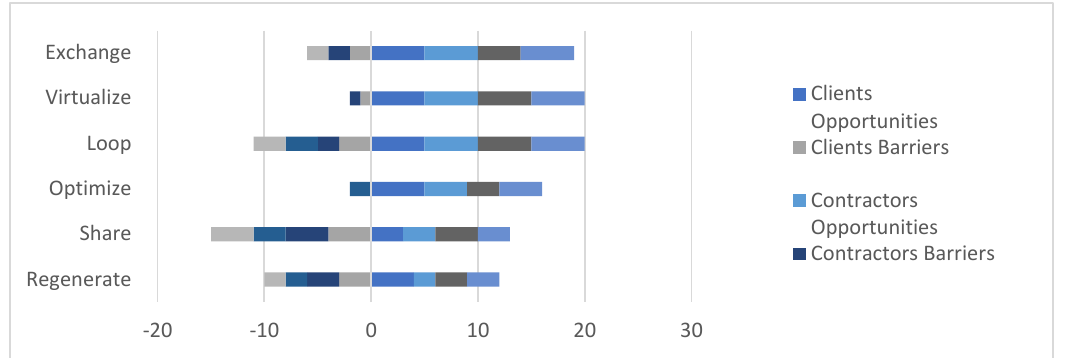
Figure 3. Barriers and opportunities score based assessment in terms of ReSOLVE framework.